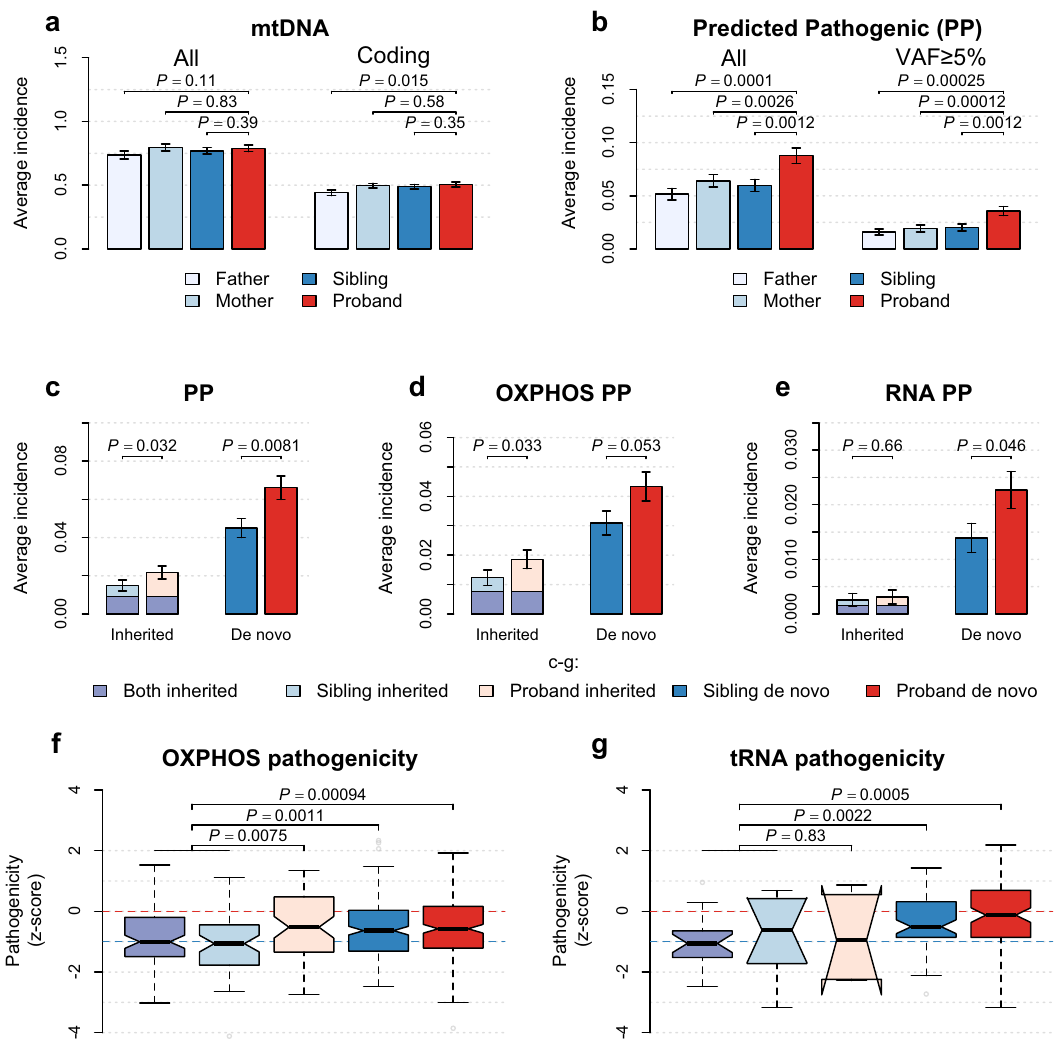
Fig. 2 mtDNA heteroplasmies in the SSC. a , b Bar plots for the average number of heteroplasmies per participant a for all mtDNA heteroplasmies and heteroplasmies in the coding region, respectively; and b for predicted pathogenic (PP) heteroplasmies. ( c ) Bar plots for the average number of inherited and de novo PP heteroplasmies in probands and siblings. d , e Bar plots for the average number of PP heteroplasmies in oxidative phosphorylation (OXPHOS) genes ( d ) and in RNA genes ( e ) among probands and siblings. Data in bar plots ( a – e ) are mean ± SEM among 1938 families in the SSC as illustrated in Fig. 1a. Distributions of the number of mtDNA heteroplasmies per participant in a and b are shown in Supplementary Fig. 1. Two-sided P values from conditional logistic regression are shown. f , g Box plots for the distribution of pathogenicity z-scores among nonsynonymous heteroplasmies (from left to right, n = 89, 58, 65, 221, and 229) in OXPHOS genes ( f ) and among heteroplasmies (from left to right, n = 21, 10, 6, 67, and 102) in tRNA genes ( g ), to illustrate weakened effects of purifying selection on mtDNA heteroplasmies among children with ASD relative to their siblings. Box plots in f and g show the median as the center line, 95% con fi dence interval of the median as the notch, the fi rst (Q1) and third (Q3) quartiles as the boundaries of the box, the values of the largest and smallest data points within the range between Q1 – 1.5× interquartile range (IQR) and Q3 + 1.5× IQR as the boundaries of the whiskers, and the outliers beyond this range as the gray points. P values (two-sided) in f and g are from the unpaired t